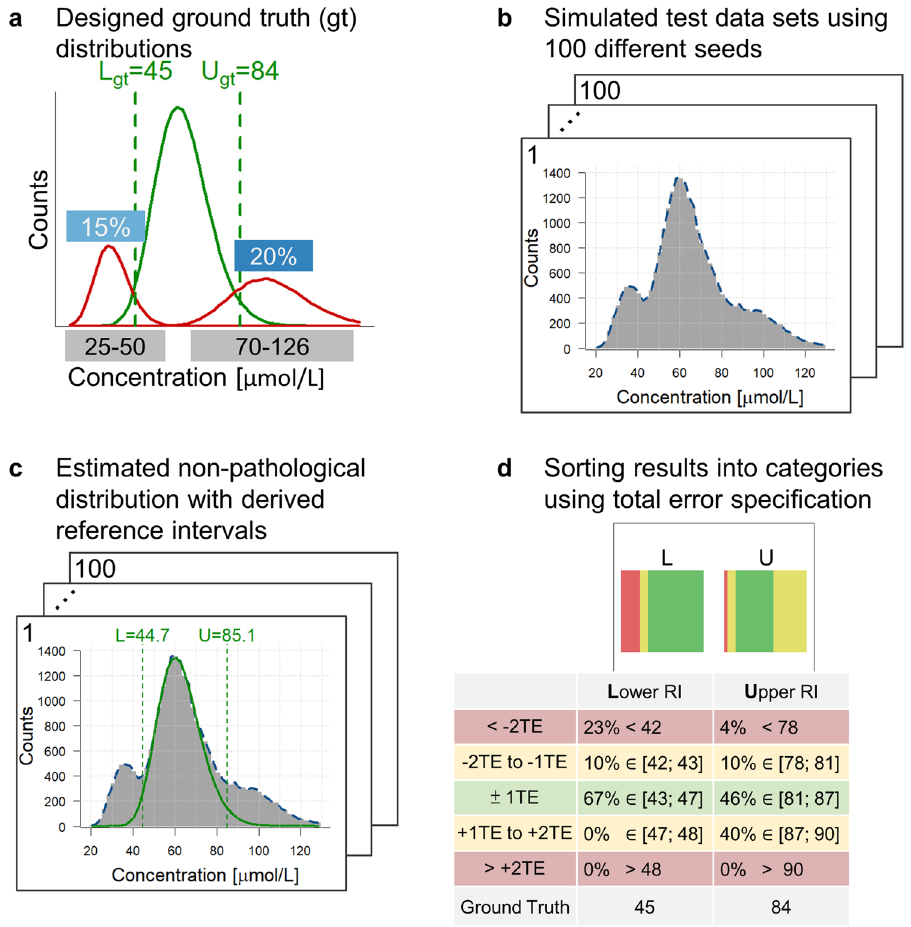
Figure 2. Description of generating simulated test cases and benchmarking the resulting estimations using an example picked from Fig. 3b (‘CREA’). ( a ) Example of designed ground truth distribution for ‘CREA’ in green with added pathological distributions left (25–50) (15%) and right (70–126) (20%) of the non-pathological distribution in red. ( b ) Simulated test datasets using 100 different seeds that serve as input to the algorithms. ( c ) Results obtained using the refineR algorithm on datasets shown in ( b ) with the green horizontal dashed lines showing the estimated reference interval and the green curve showing the estimated non-pathological distribution. ( d ) Visualization of the results for the simulated datasets shown in ( b ) with 100 different seeds and applying the algorithm on the various datasets ( c ). The obtained estimated reference intervals are grouped into the color-coded categories regarding their deviation from the ground truth (Table 1). L lower reference limit, U upper reference limit, TE total error, RI reference